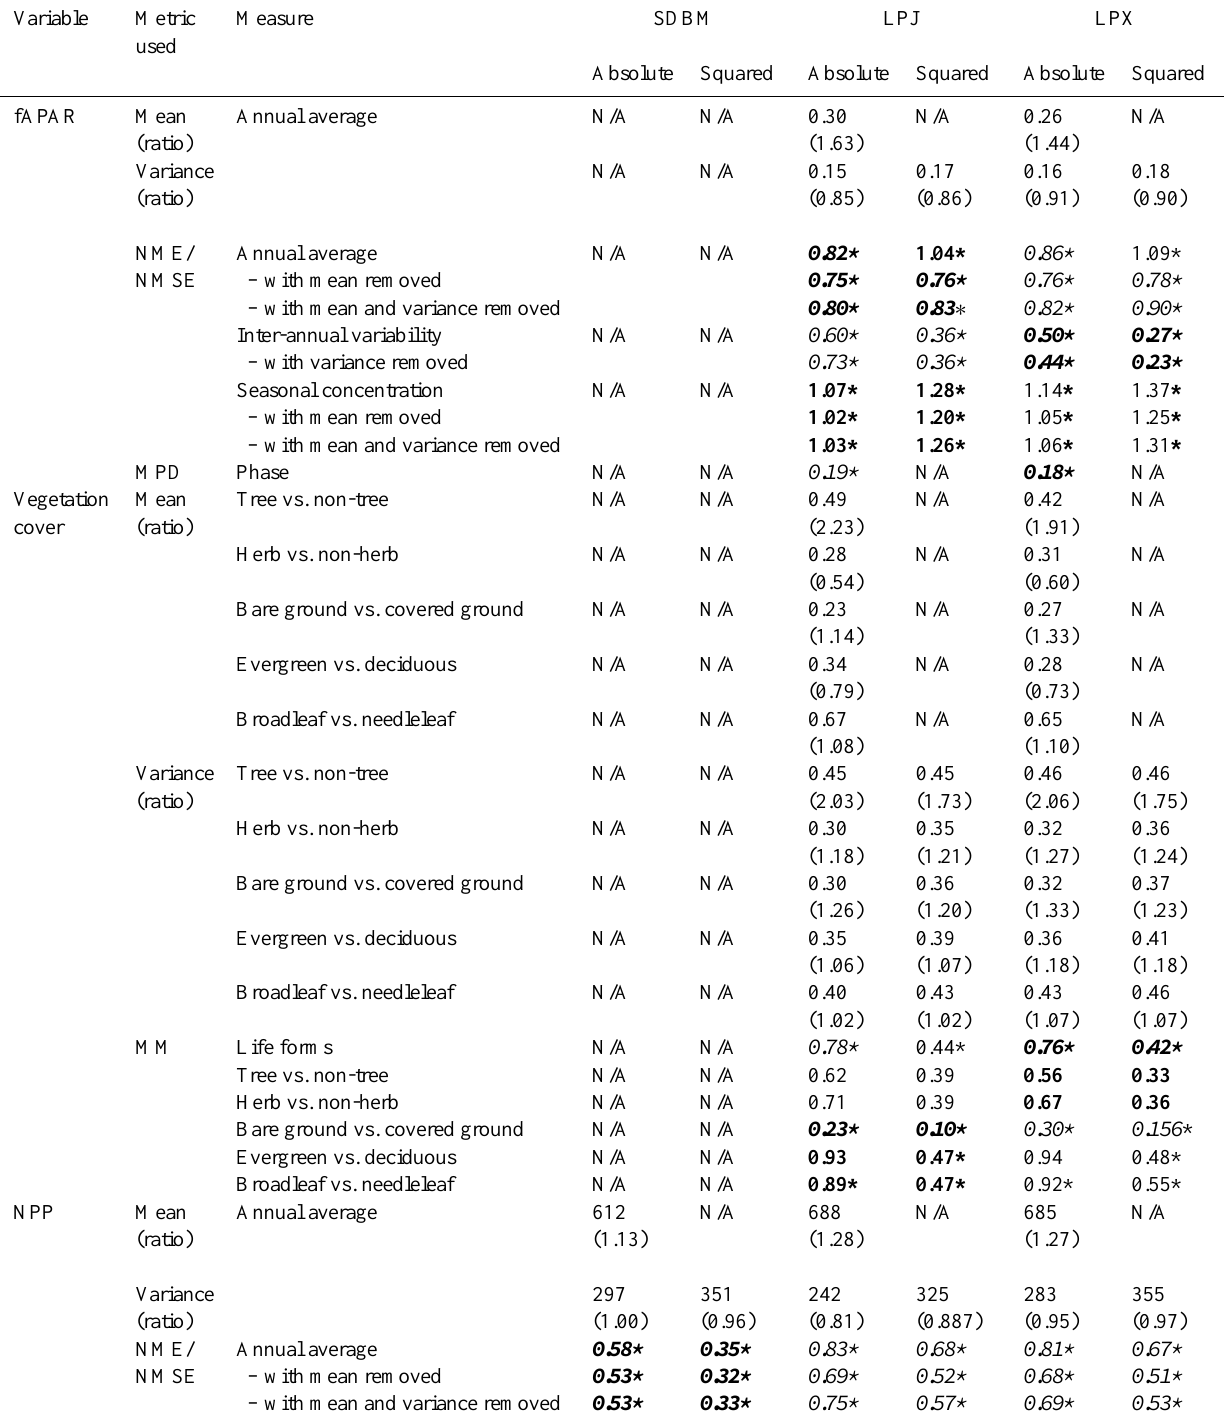
Table 5. Comparison metric scores for model simulations against observations. Mean and variance rows show mean and variance of simula- tion for annual average values, followed in brackets by the ratio of the mean/variance with observed mean or variance in Table 3. Numbers in bold indicate the model with the best performance for that variable. Italic indicates model scores better than the mean of the data score listed in Table 4. Asterisks indicate model scores that are significantly better than randomly resampling listed in Table 4. NME/NMSE denotes the normalised mean error/normalised mean squared error, MPD the mean phase difference and MM/SCD the Manhattan metric/squared chord distance metrics. fAPAR is the fraction of absorbed photosynthetically active radiation, NPP net primary productivity, and GPP gross primary